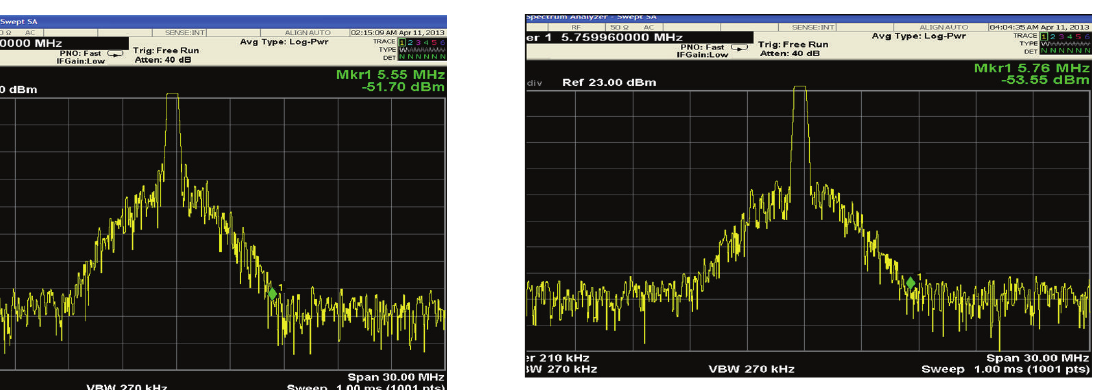
represents the minimum 0 to maximum 511 units, and 𝑦 -axis represents minimum − 8192 to maximum 8191 units.